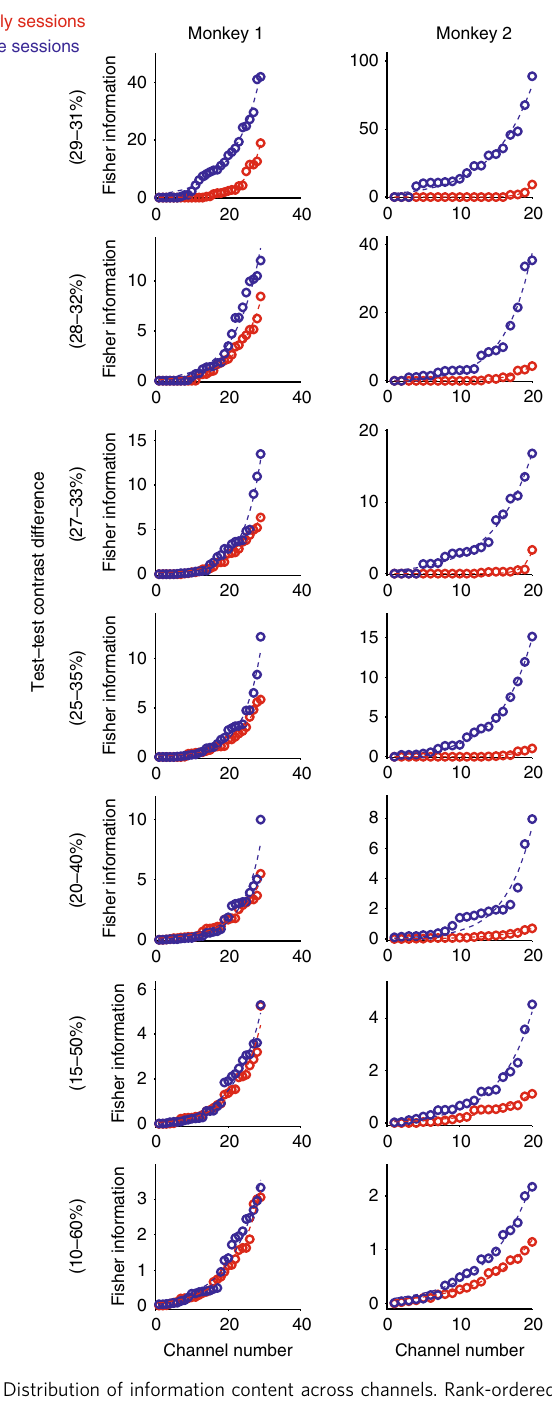
Fig. 5 Distribution of information content across channels. Rank-ordered information content in single channels for different contrast pairs during early (red) and late (blue) periods of learning. In both monkeys, a sizeable number of channels encoded relatively little information during early or late training days. Differences between training days are most obvious for channels with comparatively high information